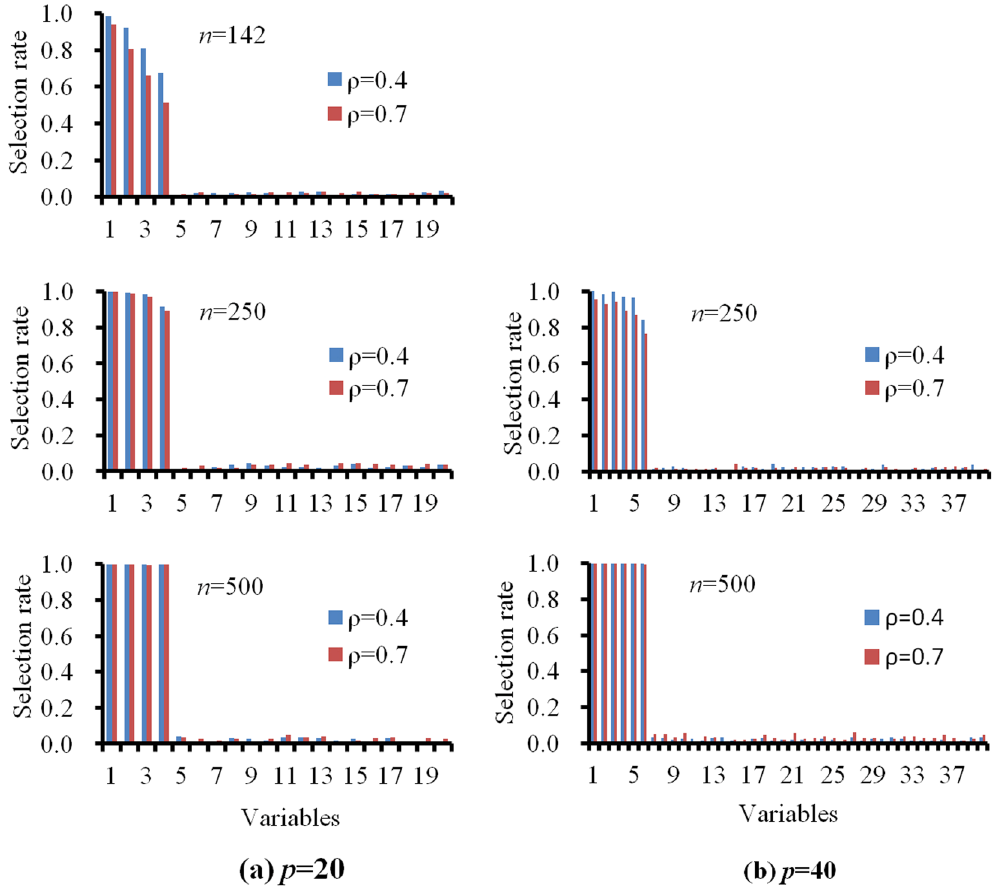
Figure 1. Performance of the pQIF for different sample sizes and different dimensions. ( a ) p = 20, ( b ) p = 40. The horizontal axis represents the variables, where 1 represents covariate age, 2–4 represent the three gene variables (MAP4, TNN, and NRF1) when p = 20, and 2–6 represent the five gene variables (MAP4, TNN, LEPR, FLT3, and NRF1) when p = 40, others represent the noise variables. The true and working correlation structures were set as AR(1). The title of each subfigure (e.g., “ n = 142” in the top left panel) refers to the sample size. Since the pQIF did not converge well for n = 142, p = 40 in some simulations runs, the estimation results were not listed in the figure.